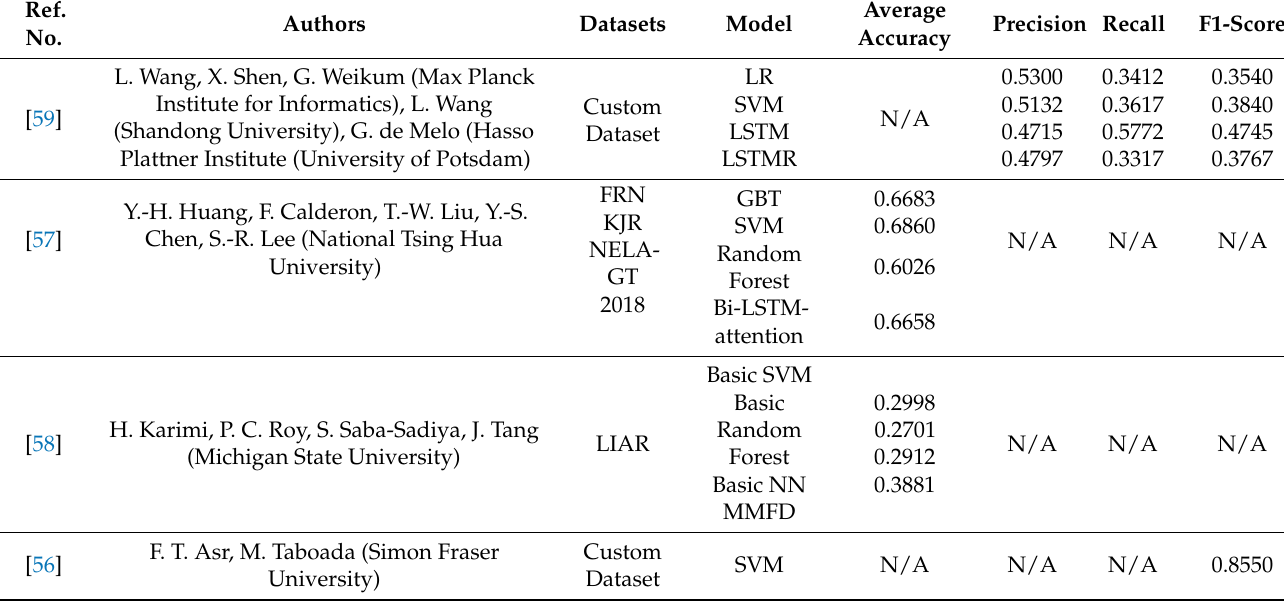
Table 12. Performance Evaluation of Cross-Source Methodologies.